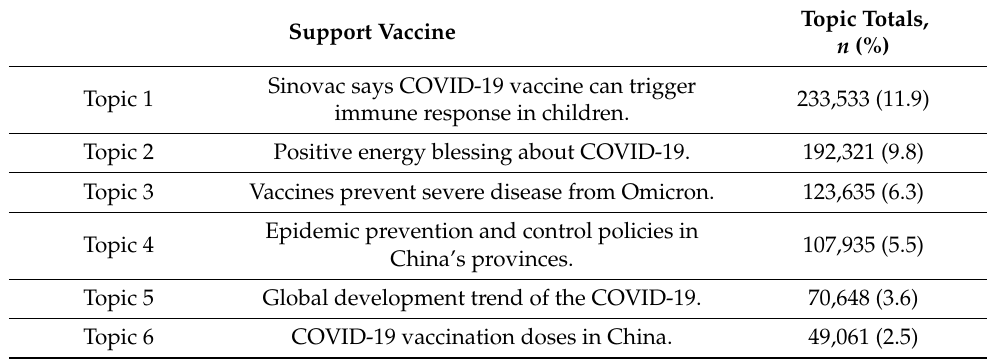
Table 1. The six most significant vaccine-related topics of the vaccine-supportive group ( n = 1,962,464).